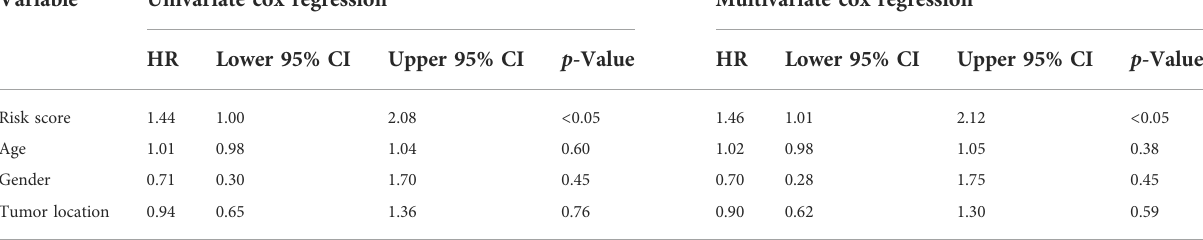
TABLE 6 Comparisons between the risk score and other four variables, including age, metastasis, gender, and primary tumor site in the GSE21257 dataset using univariate and multivariate Cox regression analyses.